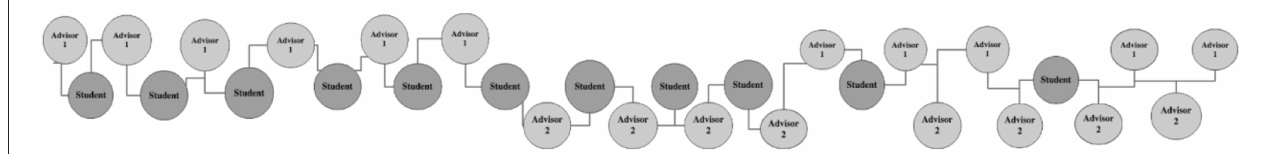
FIGURE 3 | Visualization of the Franklin conferring process created by the site captain. This figure represents the conferring process of one advisory session with two advisors and one student. In this instance, the student mostly responded to questions from the advisors and the student spoke less often toward the end of the